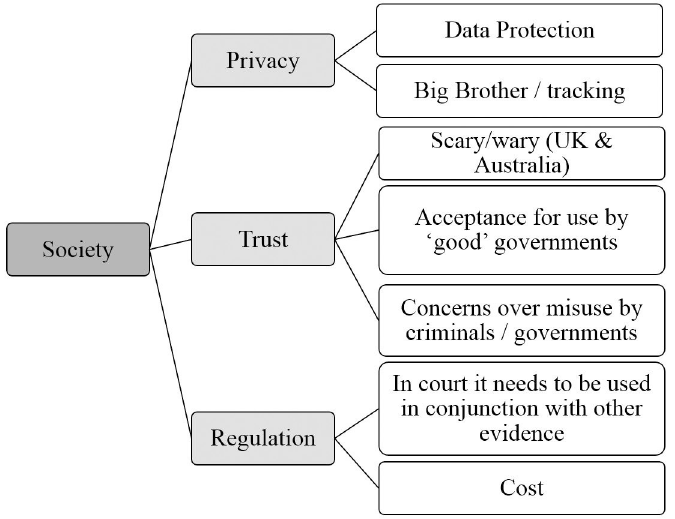
Fig 2. Society overarching theme. Graphical representation of Society overarching theme and its component themes and subthemes identified from focus groups conducted in the UK, Australia and China.